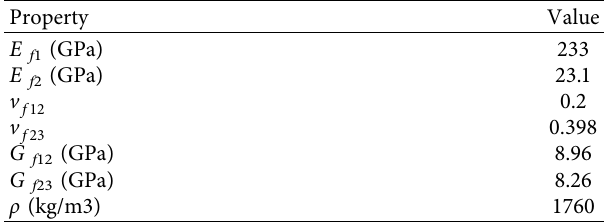
Table 3: Mechanical property of T300. Property